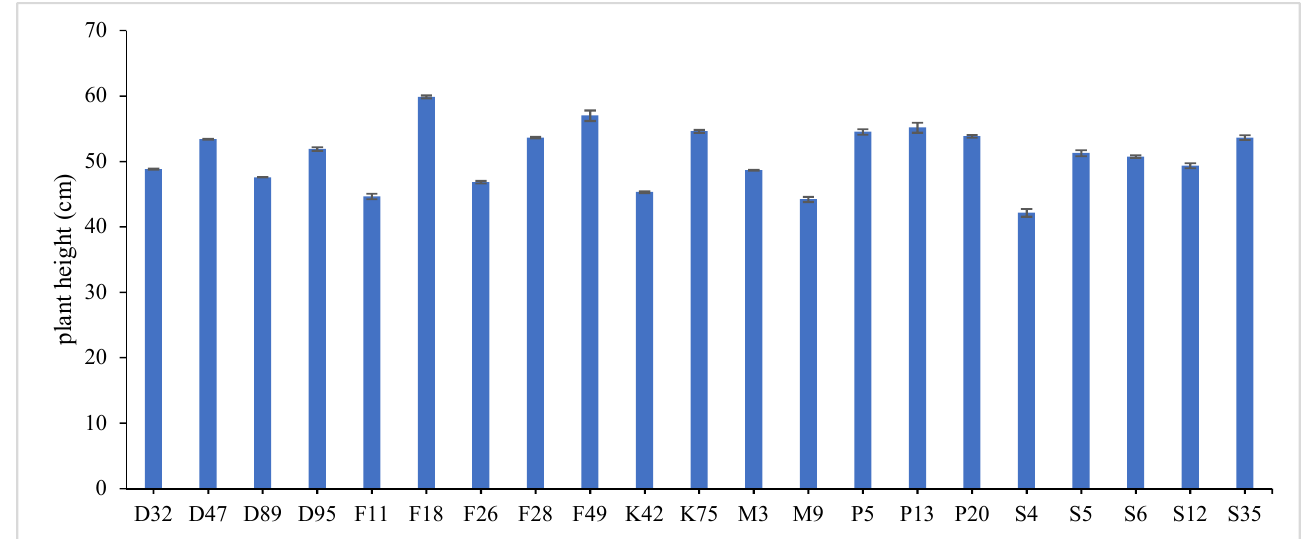
Figure 1. Mean performance of plant height, of twenty-one alfalfa genotypes at combined across the two years. Bar represents the standard deviation.